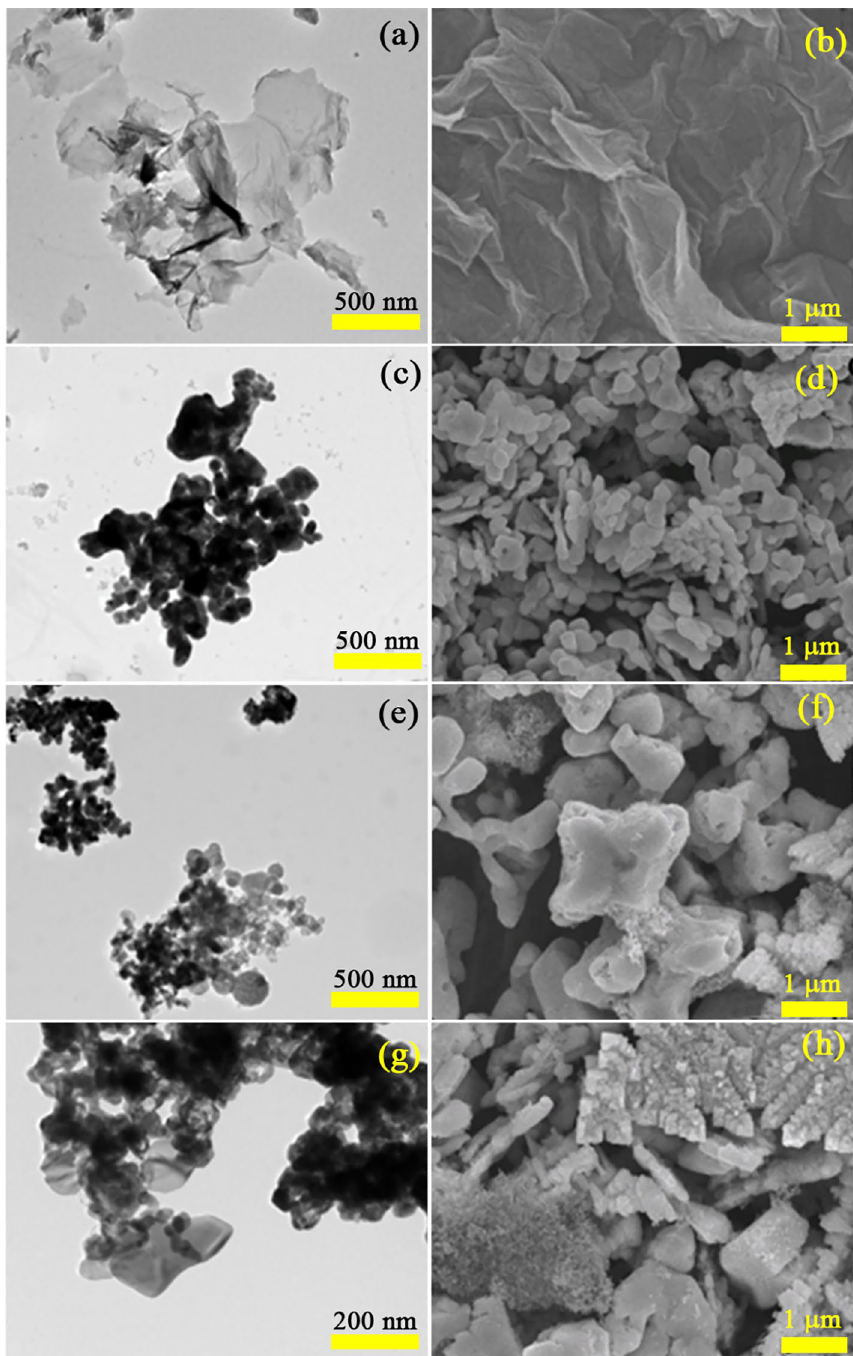
Figure 2. TEM and SEM images of GO ( a , b ), BiVO 4 ( c , d ), BiVO 4 /SiO 2 ( e , f ) and BiVO 4 /SiO 2 /GO ( g , h